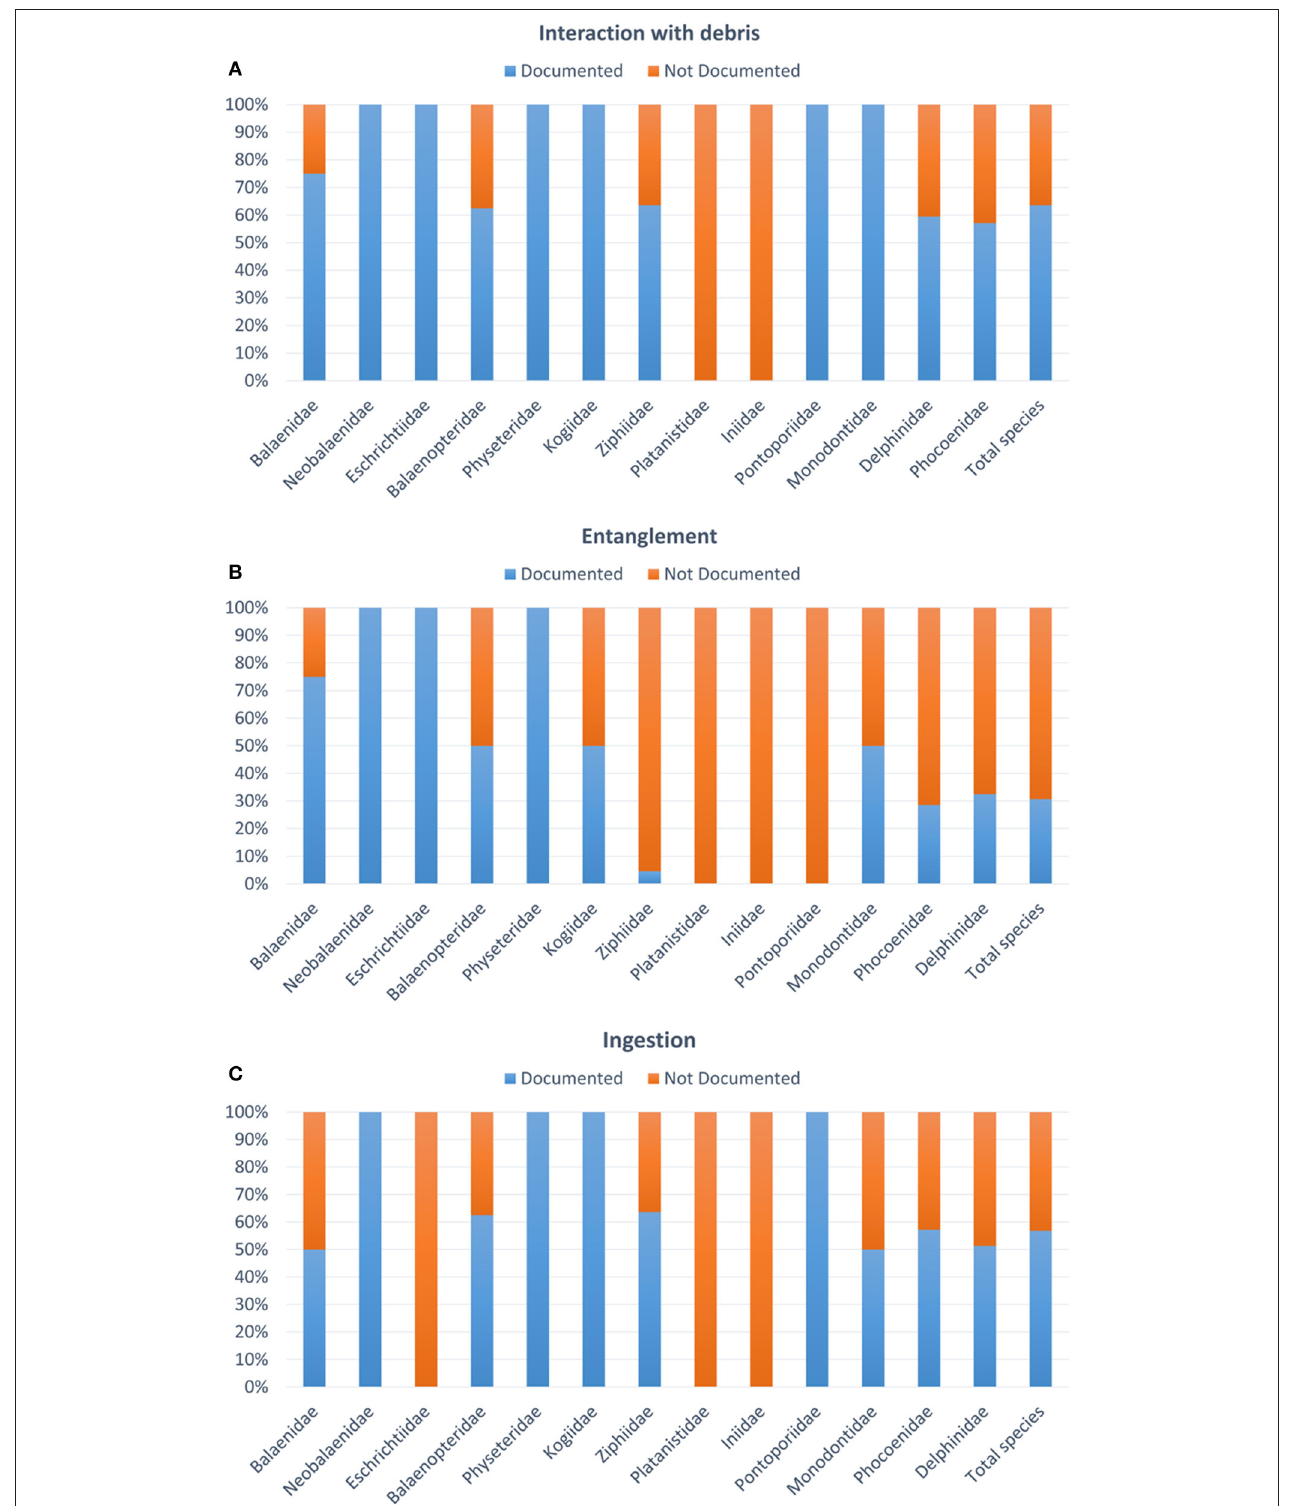
FIGURE 1 | Percentage of studied species for debris in relation to the total number of species per family in the order Cetaceans. (A) Interaction with debris including both entanglement and ingestion; (B) percentage of species with documented/not documented entanglement; (C) percentage of species with documented/not documented